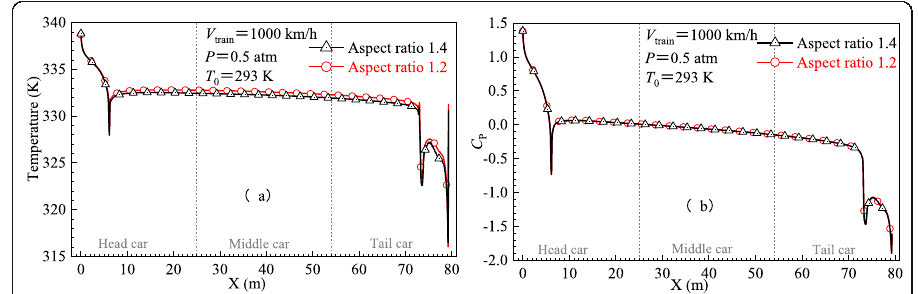
Fig. 6 Temperature ( a ) and C P ( b ) distribution on the intersection line between the train upper surface and the xy plane at different stretching